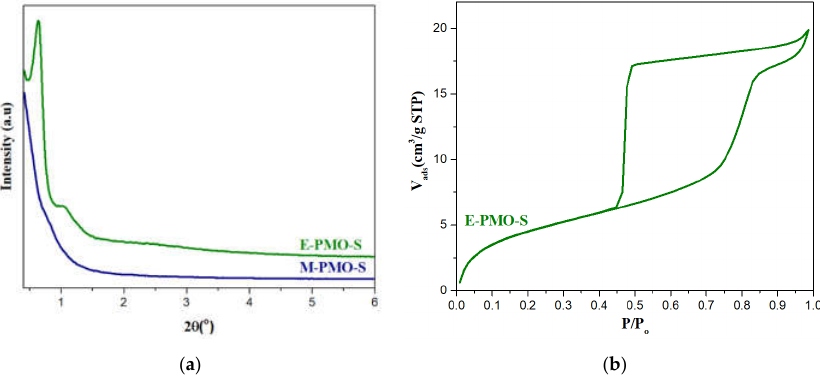
Figure 8. ( a ) Low angle XRD patterns; ( b ) N 2 adsorption-desorption isotherm of E-PMO-S.